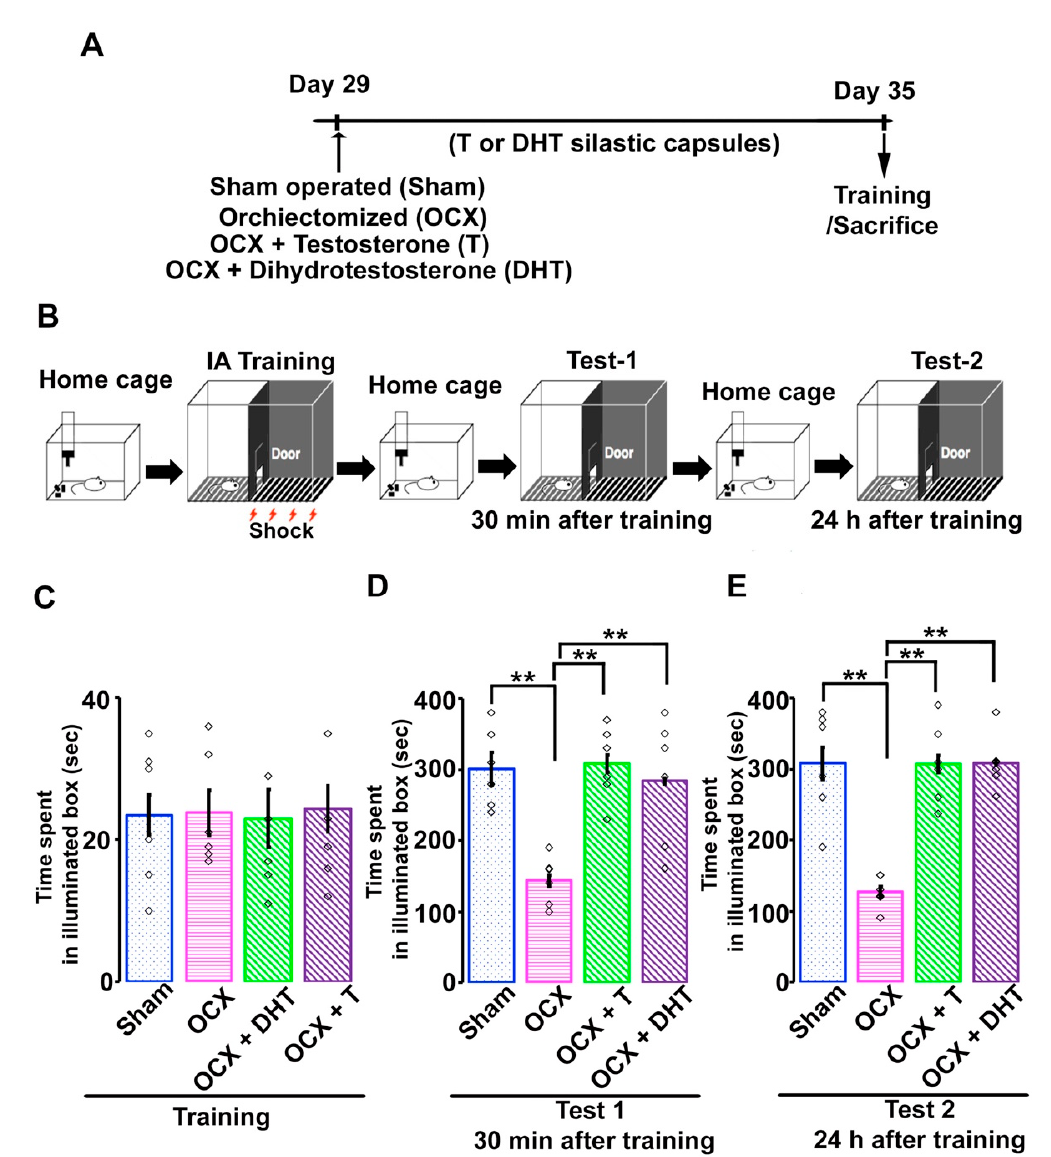
Figure 1. Time spent in illuminated box before entering the dark compartment of the box in sham-operated and steroid-manipulated male rats. ( A ) Schematic diagram of the schedule for surgical operations. ( B ) Diagram of experimental design and inhibitory avoidance task. A brief electrical foot-shock (2 s) was applied in the dark shock cage. ( C ) Time spent in illuminated box before training and ( D ) thirty minutes or ( E ) 24 hours after training of sham-operated and hormonal-manipulated rats. Values are the mean ± SEM. ** p < 0.001. n = 6 for each group. White rectangles in ( C – E ) represent data